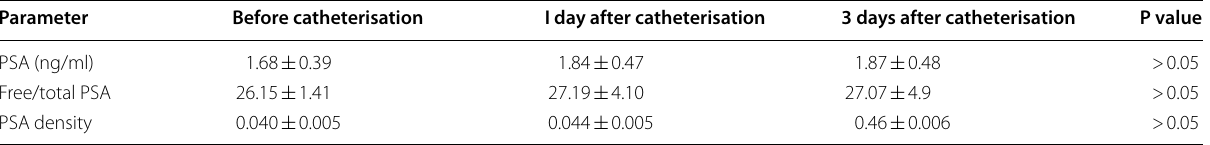
Table 2 PSA, PSA density and free/total PSA levels in Group B